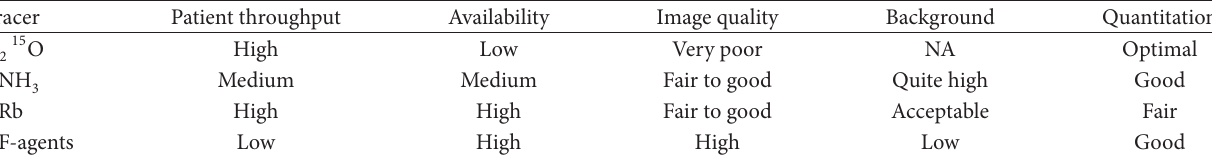
T 1: Comparison of the features of the main PET myocardial perfusion